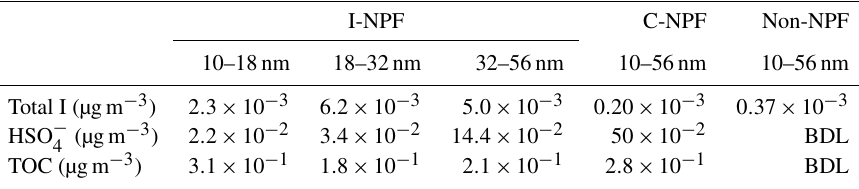
Table 1. Concentrations of total iodine (I), HSO − and total organic carbon (TOC) in three size bins between 10–56nm during the I-NPF, 4 C-NPF and non-NPF days. For simplicity, only the sum of three size bins is are shown for the C-NPF and non-NPF days. BDL: below detection limit.